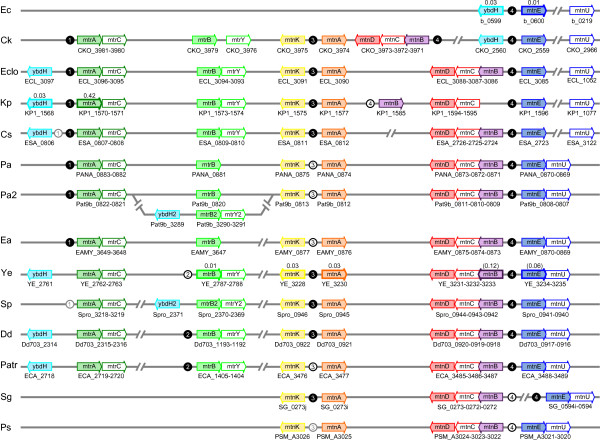
Genomic organization of the genes of the methionine salvage pathway. The different patterns are represented by one species for each genus with a unique pattern: Ec, Escherichia coli K12 MG1655; Ck, Citrobacter koseri; Eclo Enterobacter cloacae ATCC 13047; Kp, Klebsiella pneumoniae NTUH-K2044; Cs, Cronobacter sakazakii; Pa, Pantoea ananatis; Pa2, Pantoea sp. At-9b; Ea, Erwinia amylovora; Ye, Yersinia enterocolitica; Sp, Serratia proteamaculans; Dd, Dickeya dadantii Ech703; Patr, Pectobacterium atrosepticum; Sg, Sodalis glossinidius; Ps, Pseudoalteromonas sp. SM9913. Genes are color-coded and spaces have been introduced between adjacent genes in order to align homologs vertically. Pseudogenes in S. glossinidius have letters after the locus number. In cases where a large number of other genes intervene between those of interest, a separation symbol is used://. Groups of metboxes are indicated by circled numbers based on which genes they are adjacent to. These are filled in black if there is strong conservation (≥70% identity to a reference species), outlined in black for weaker conservation (≥60% identity), and outlined in gray for more divergent sequences. The reference species were C. koseri for groups 1, 3 and 4; and P. atrosepticum for group 2. Genes which were tested for repression in this paper are displayed with their repression ratio above the gene arrow. In the case of Yersinia, ratios in parentheses refer to Y. pseudotuberculosis.